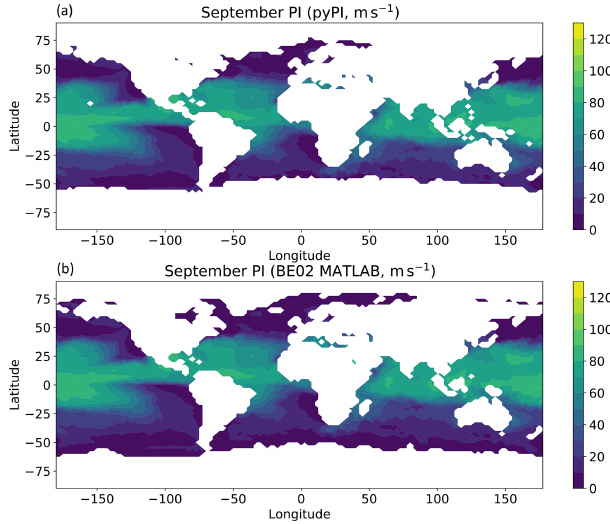
Figure 3. September 2004 mean potential intensities (ms − 1 ) calcu- lated with pyPI (a) and the BE02 MATLAB code (b) .